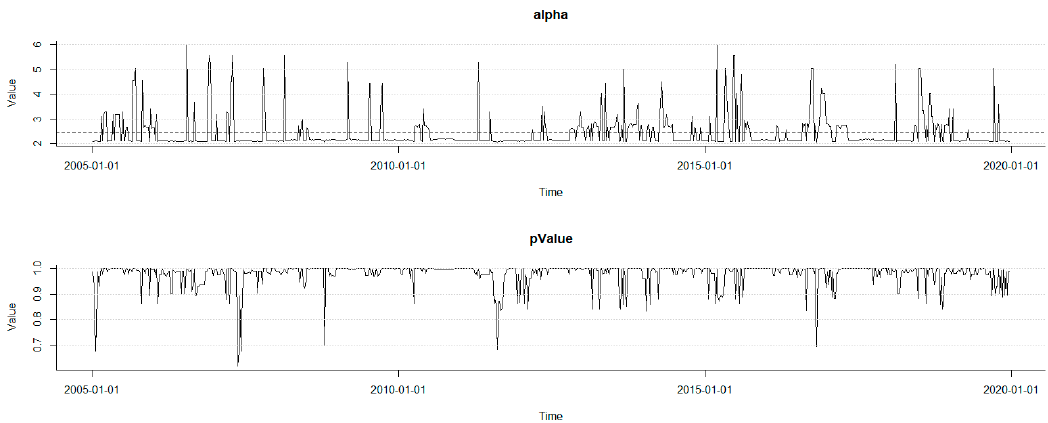
Figure 8. Estimated parameters alpha of power distribution for the minimum spanning trees (MST) from 7 January 2005 to 20 December 2019. Source: Own study.